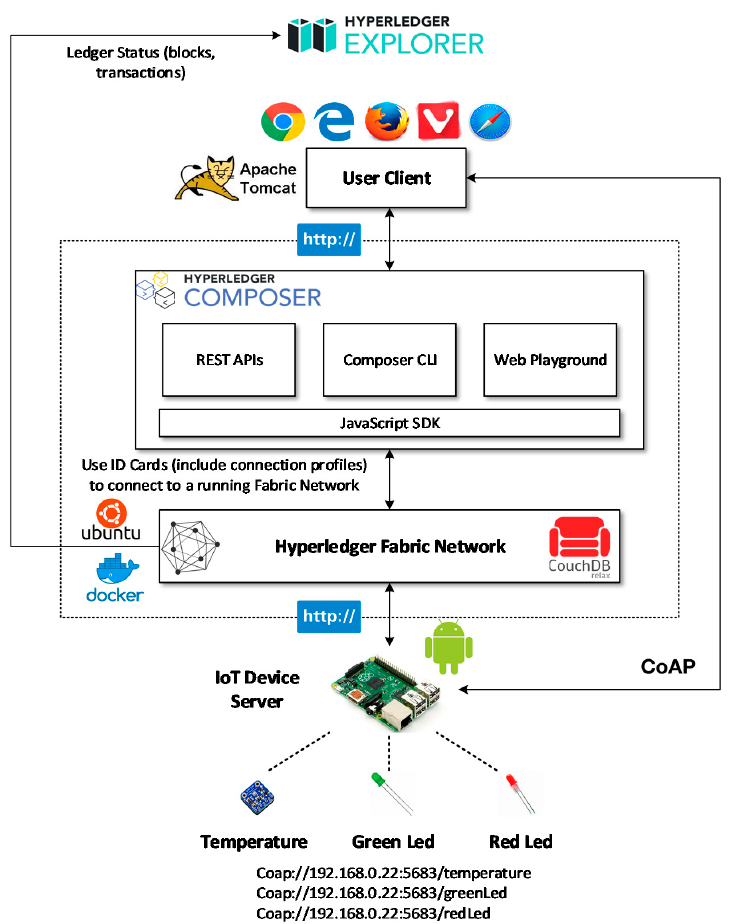
Figure 6. Development solution architecture of the prototype.